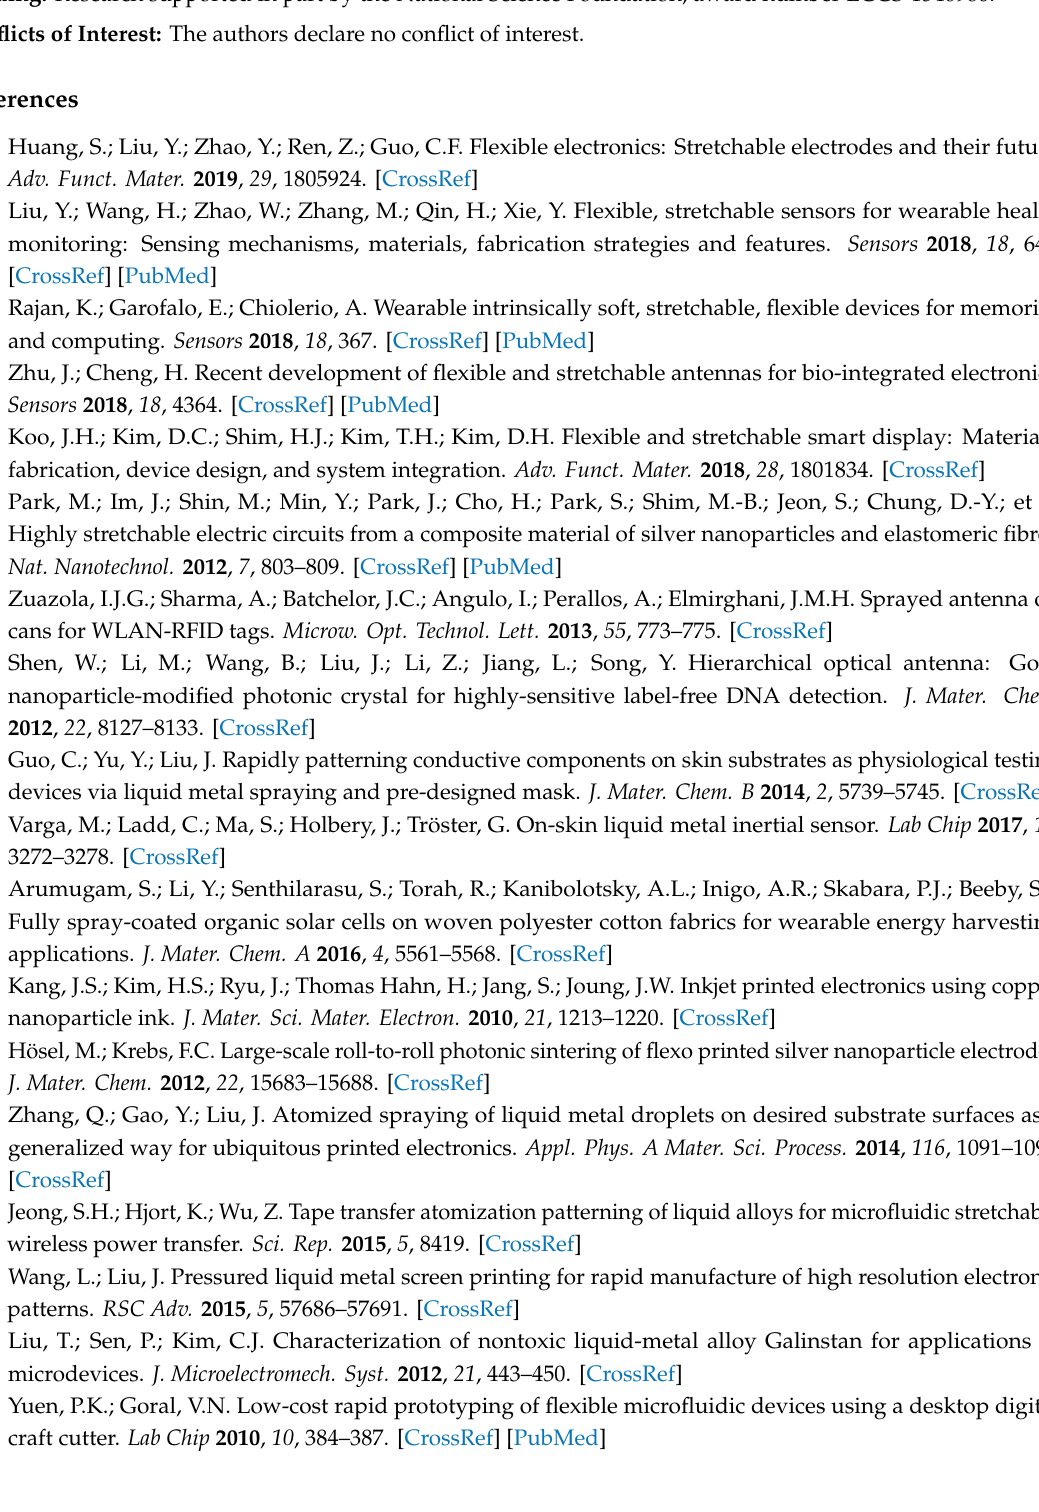
Figure S1: Simulation results for the insertion loss of as transmission line with a capacitive coupling; Figure S2: Images of the droplets sprayed at various pressures measured by a laser scanning